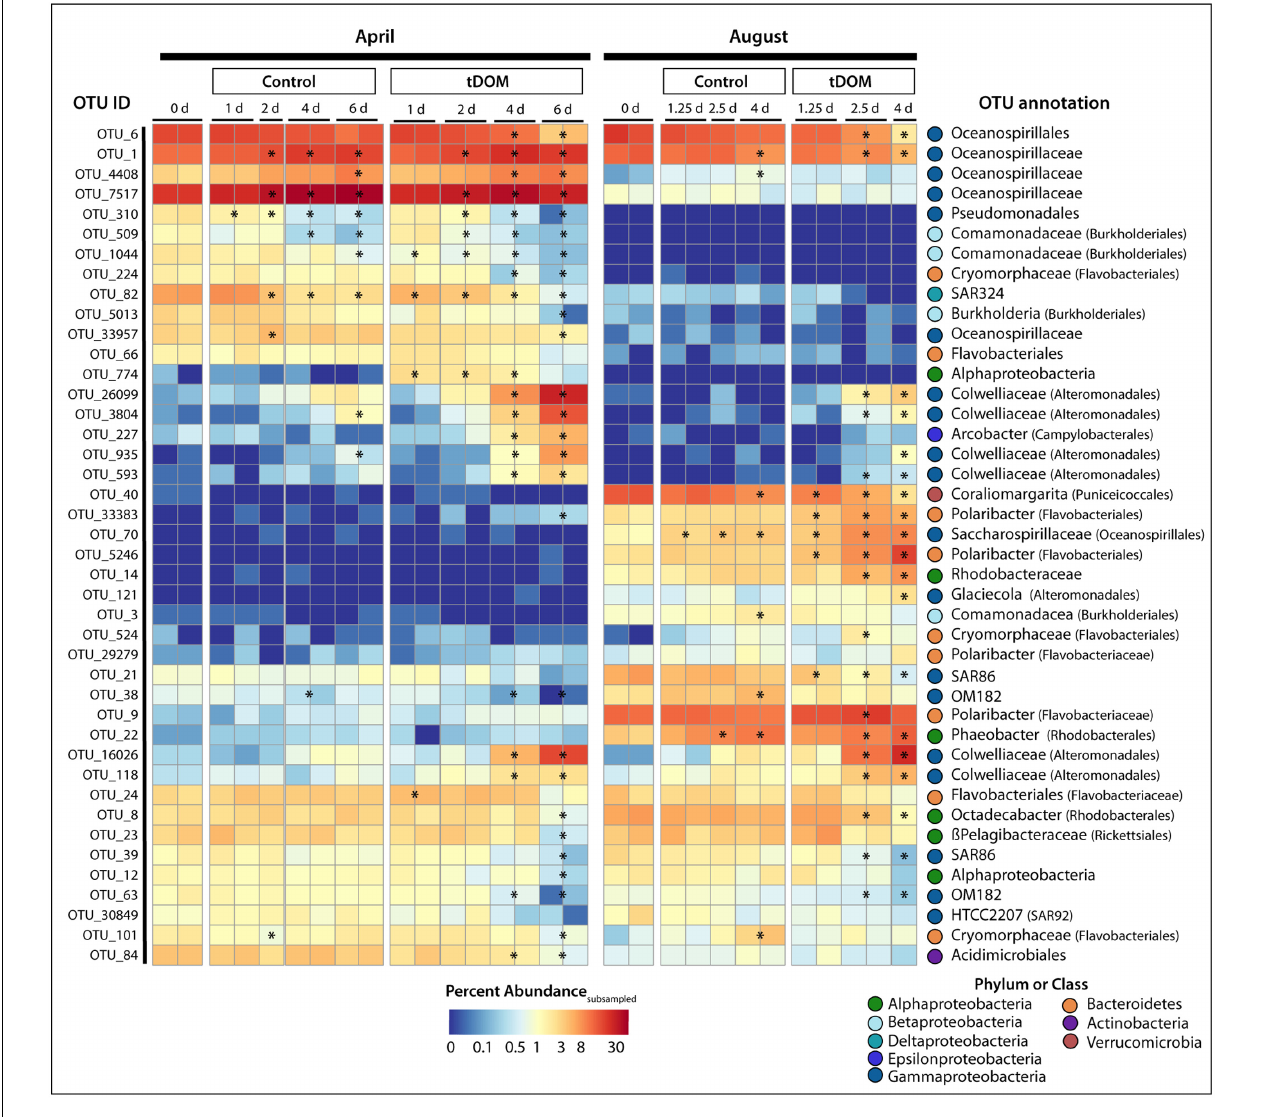
FIGURE 6 | Change in operational taxonomic unit (OTU) relative abundance. Heatmap showing the percent abundance of OTUs identified to significantly change (adjust p -value < 0.05) in relative abundance over the course of the bioassays. Plotted are OTUs that were at least 1% of the total number of subsampled sequences in at least one sample. The OTU ID is noted to the left of the heatmap while the annotation, given as the lowest taxonomic level, is to the right of the heatmap. The bioassay (April or August), treatment (Control or tDOM) and timepoint (in days) are noted above the heatmap. Finally, for each OTU, asterisks within the heatmap denote a sample or pair of samples (duplicates) that have a relative abundance that is significantly greater or less than the